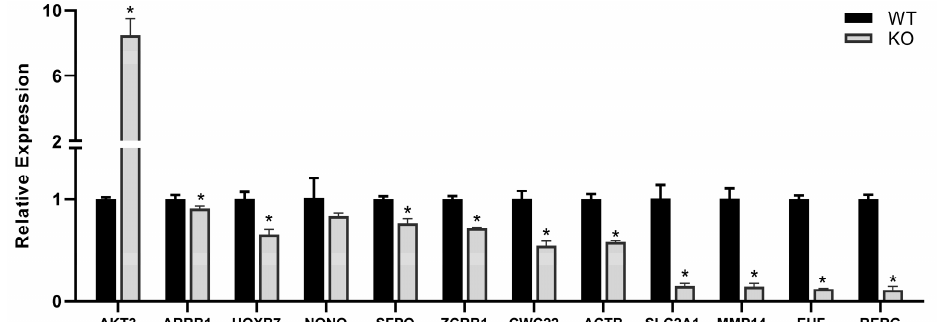
Figure 3. Differences in the expression levels of mRNAs, based on RT-qPCR results. Results significant at p > 0.005 are marked with an asterisk.